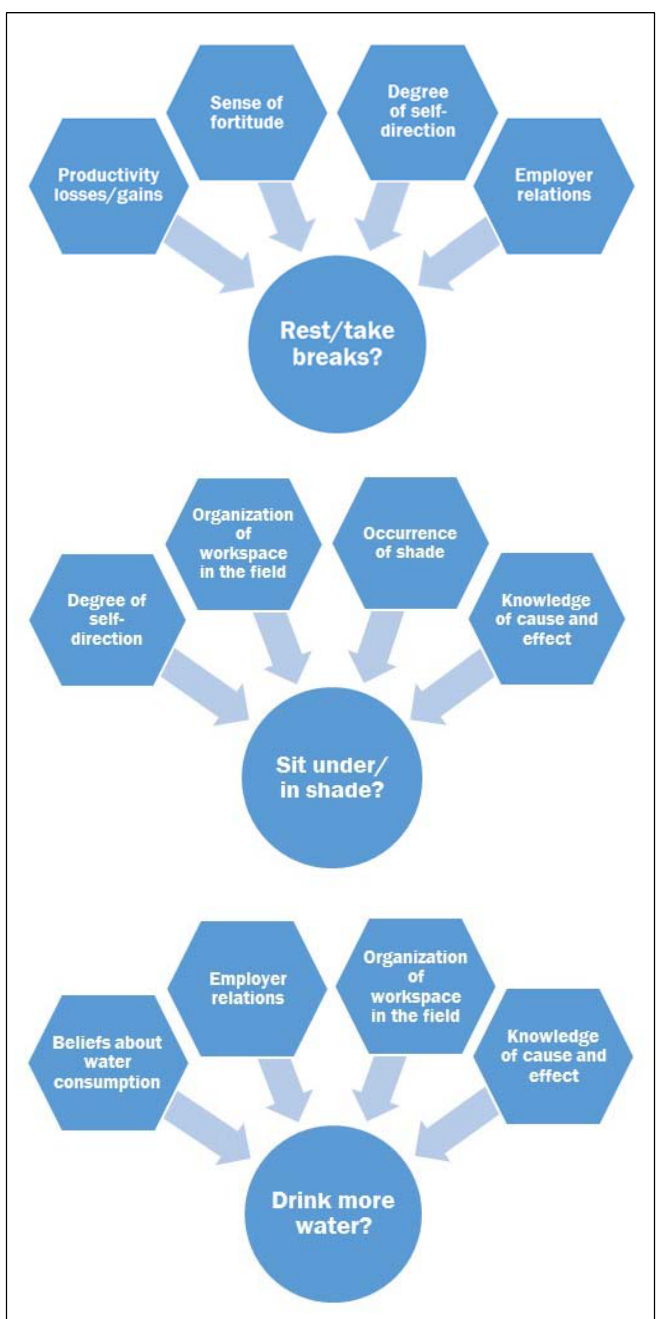
Figure 4. Select Factor Cluster Groupings Select factor cluster groupings help illustrate how self-care decisions are shaped in relation to rest, shade, and water while working in the